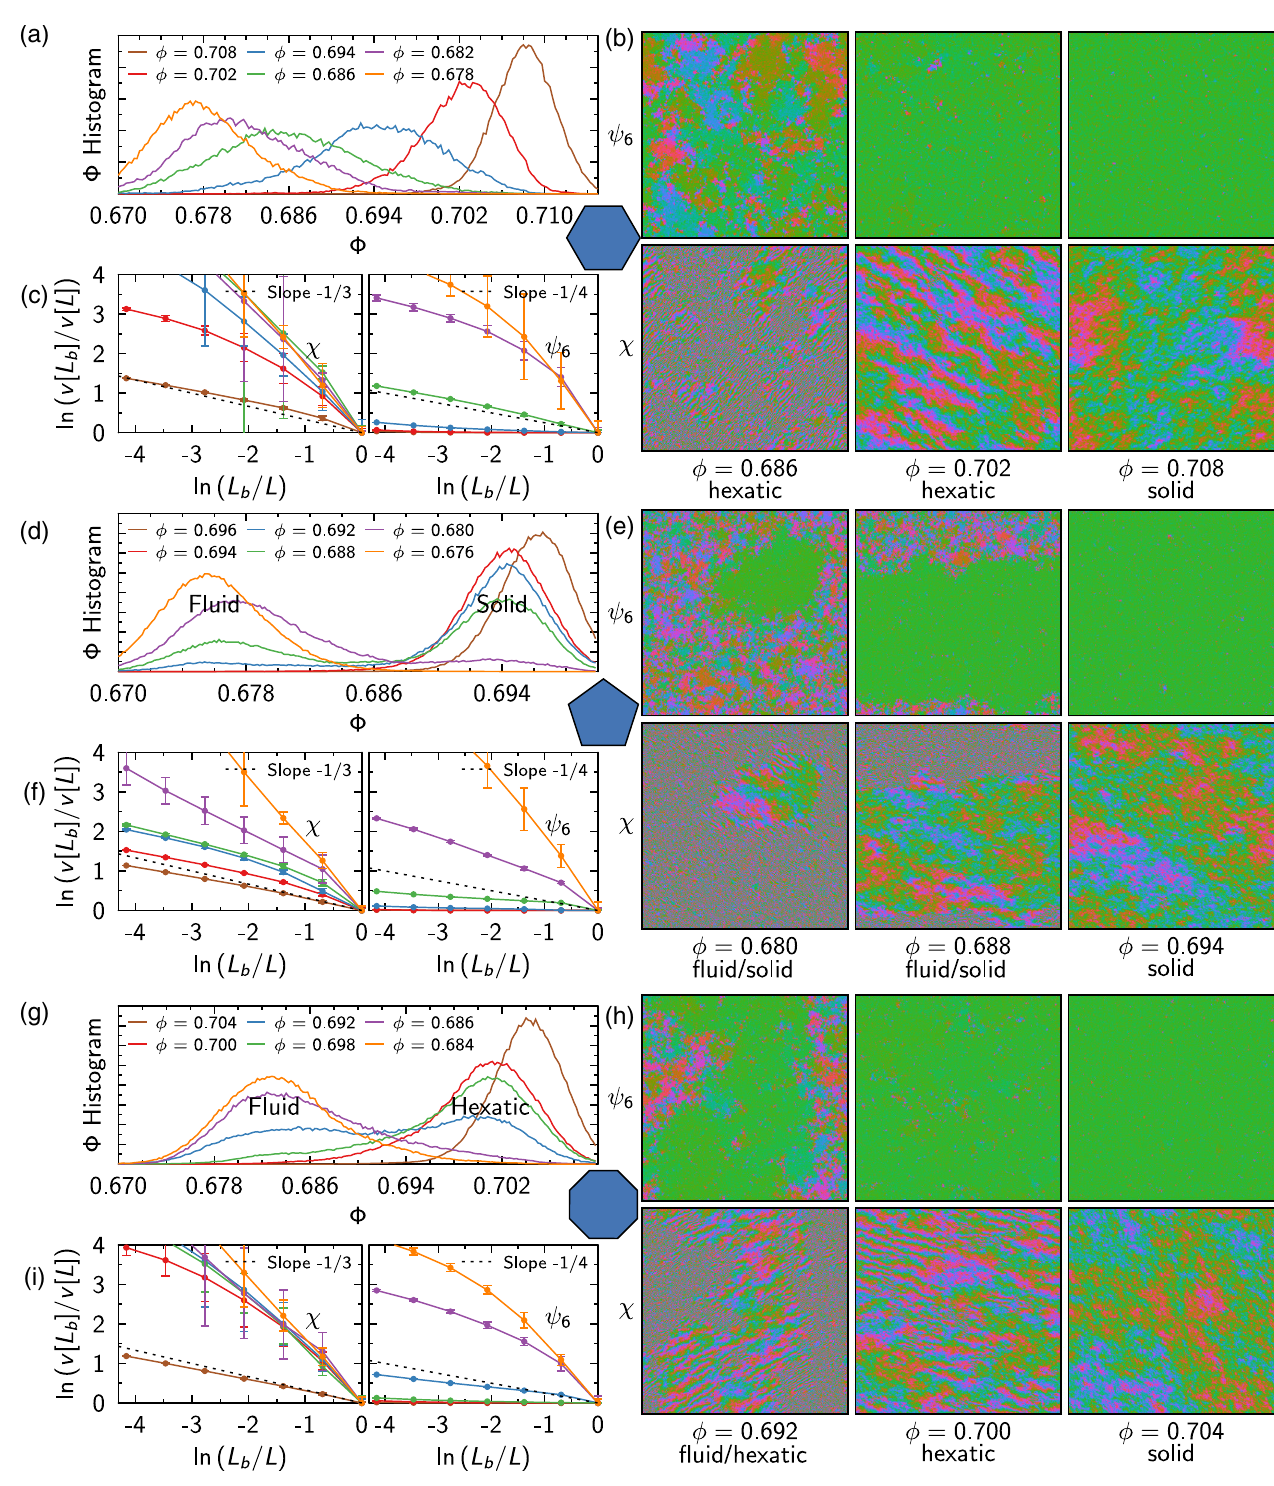
FIG. 3. Example phase transitions from the three melting scenarios. We show data for (a) – (c) hexagons ( N ¼ 512 2 ) following the continuous KTHNY scenario, (d) – (f) pentagons ( N ¼ 1024 2 ) exhibiting a first-order isotropic fluid-to- solid transition, and (g) – (i) octagons ( N ¼ 1024 2 ) following an intermediate scenario exhibiting a first-order fluid-to-hexatic transition. For each shape, the top left-hand panels show local density histograms [(a),(d),(g)]. The right-hand panels show bond and positional order parameters at selected densities [(b),(e),(h)]. The bottom left-hand panels show sub-block scaling analysis